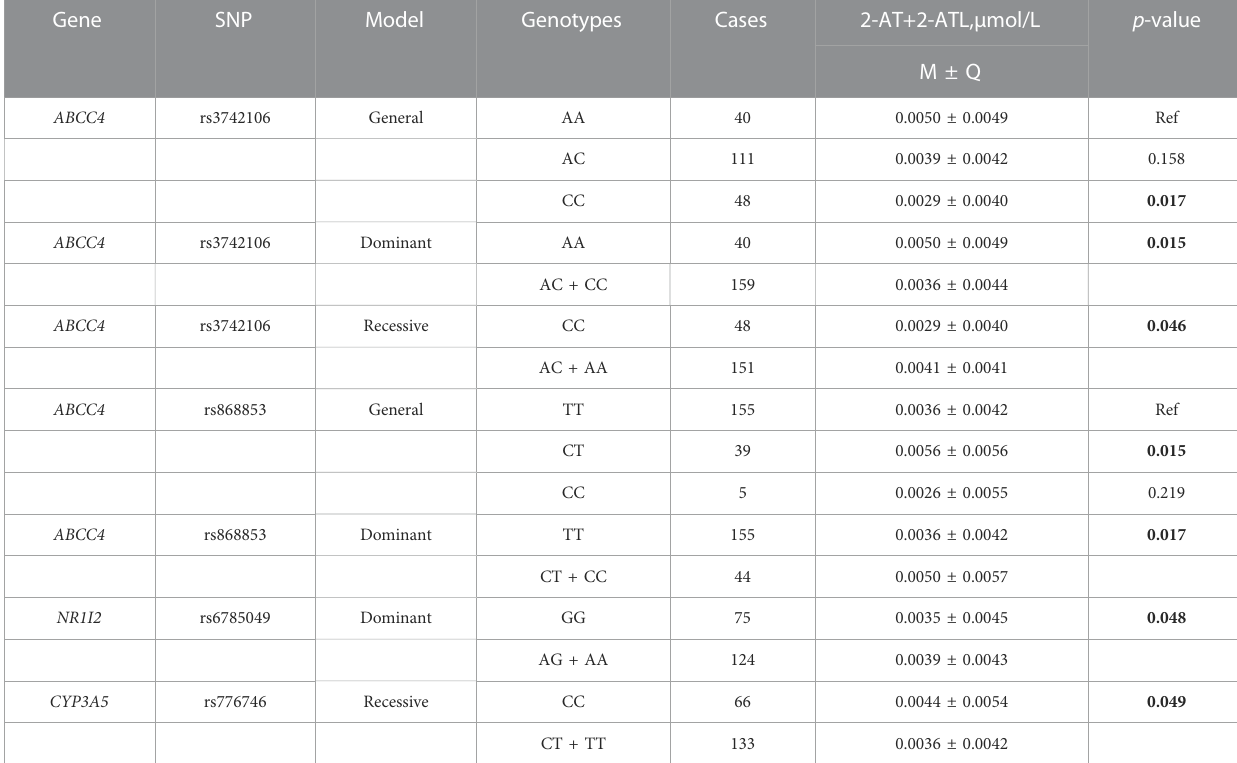
TABLE 4 Association analysis between SNP and plasma concentration of 2-AT+2-ATL. Gene